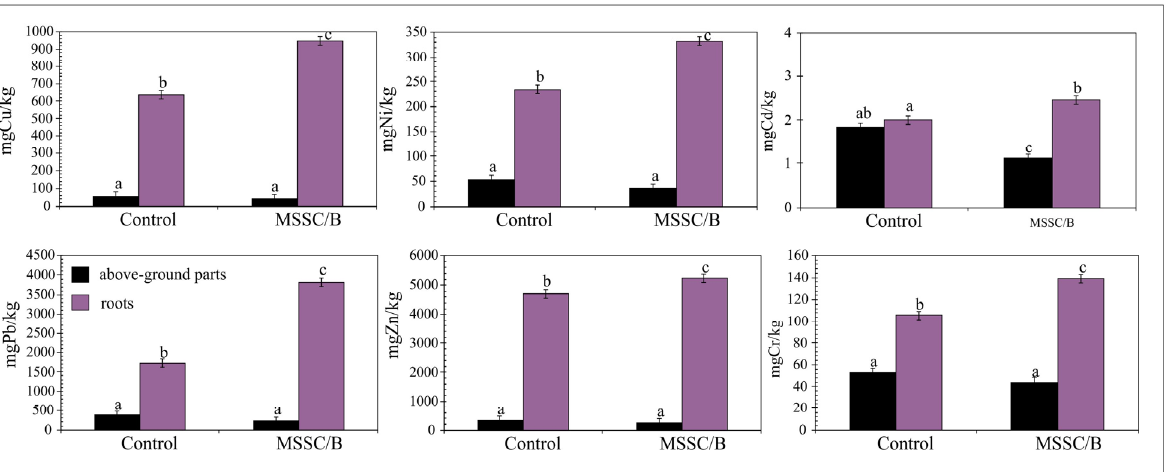
Figure 2. Effect of MSSC/B on PTE accumulation in the above-ground parts and the roots of D. glomerata . Mean ± SD with different lowercase letters indicate significant differences among treatments ( p < 0.05), analyzed using one-way ANOVA.